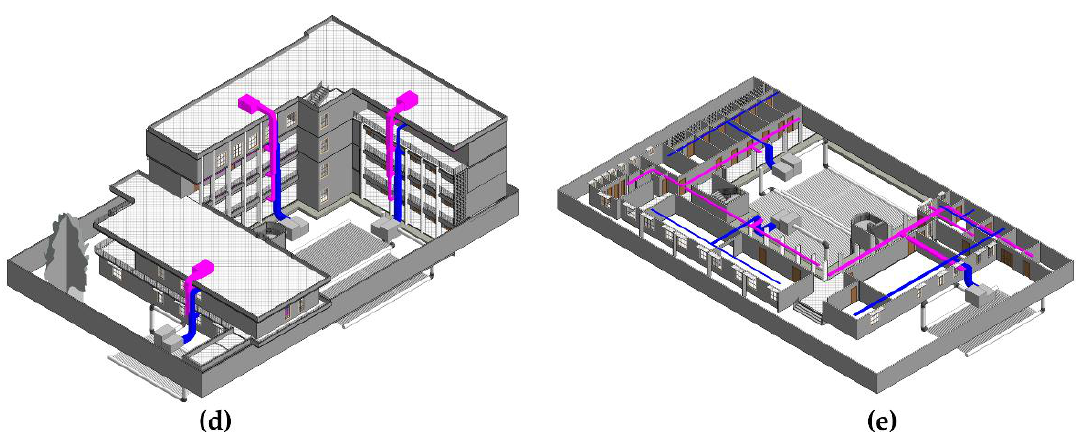
Figure 5. Spatial features of the exemplary case study ACB: ( a ) ground floor plan with the indication of EAHEs and room types, ( b ) north side elevation, ( c ) section, ( d ) view of the ACB in the south direction, and ( e ) sectional view. Legend: EAHE, earth-to-air heat exchanger; AHU, air-handling unit; C, computer lab; O, office; R, common room; I, library; Y, courtyard; T, toilet; E, canteen; P, photocopier; L, lecture hall; B, lab; D, corridor. Table 1. The thermal transmittance of the building envelope. Legend: EPS, expanded polystyrene; RCC, reinforced cement concrete; LoE, low emissivity.